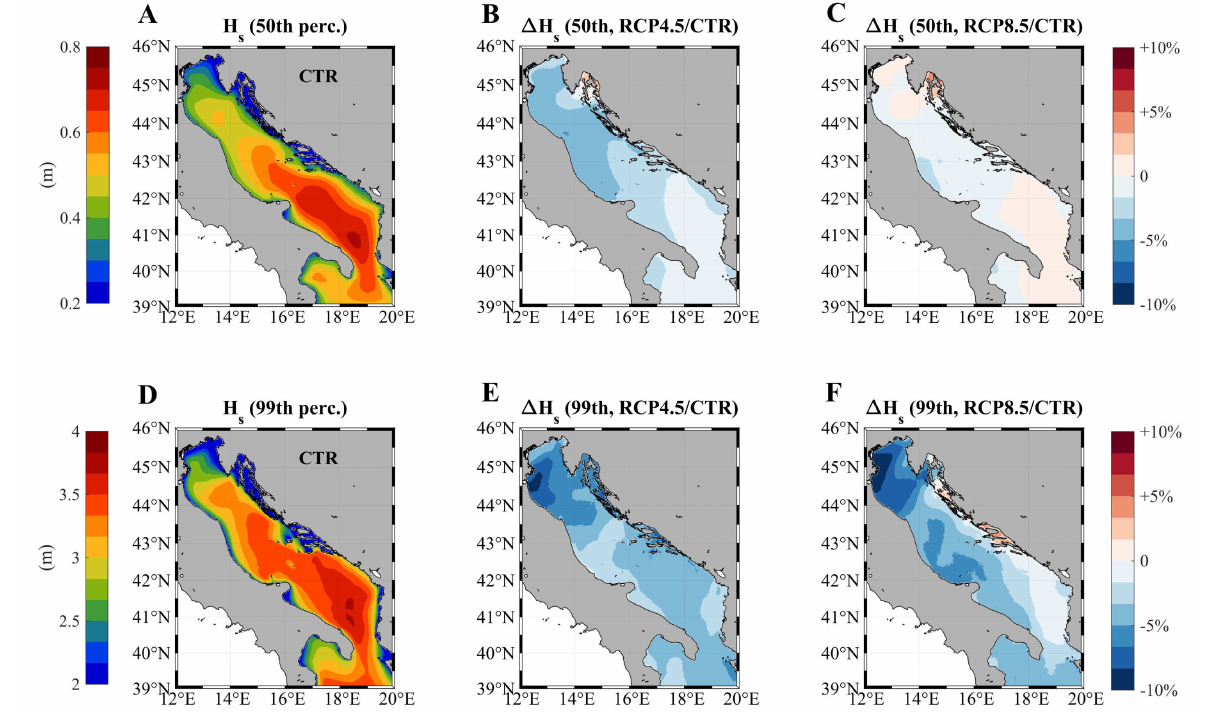
Figure 13. Climatology of the significant wave height ( H s , in meters, hourly) for the present day (1981–2010; ( A , D )) and projected relative changes for the near-future period 2021–2050 under RCP4.5 ( B , E ) and RCP8.5 ( C , F ) scenarios. Annual average of the 50th percentile ( A – C ) and 99th percentile ( D – F ) from WW3 model fields over the Adriatic Sea and the North Ionian